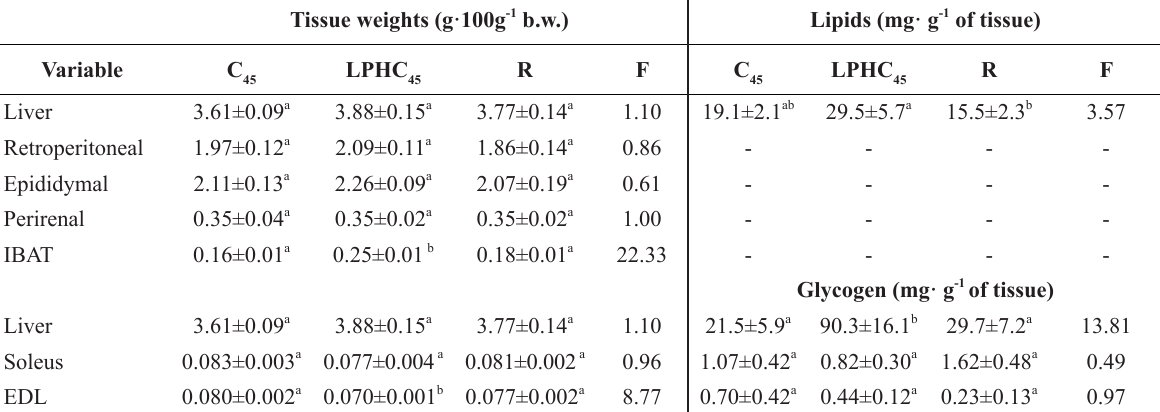
, LPHC , and R rats.* 45 45